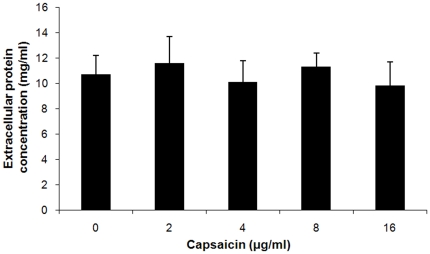
Protein contents in supernatants of S. aureus USA 300.
S. aureus USA 300 was grown in the presence or absence of increasing concentrations of capsaicin. Data are presented as the average ± SD from three independent experiments.